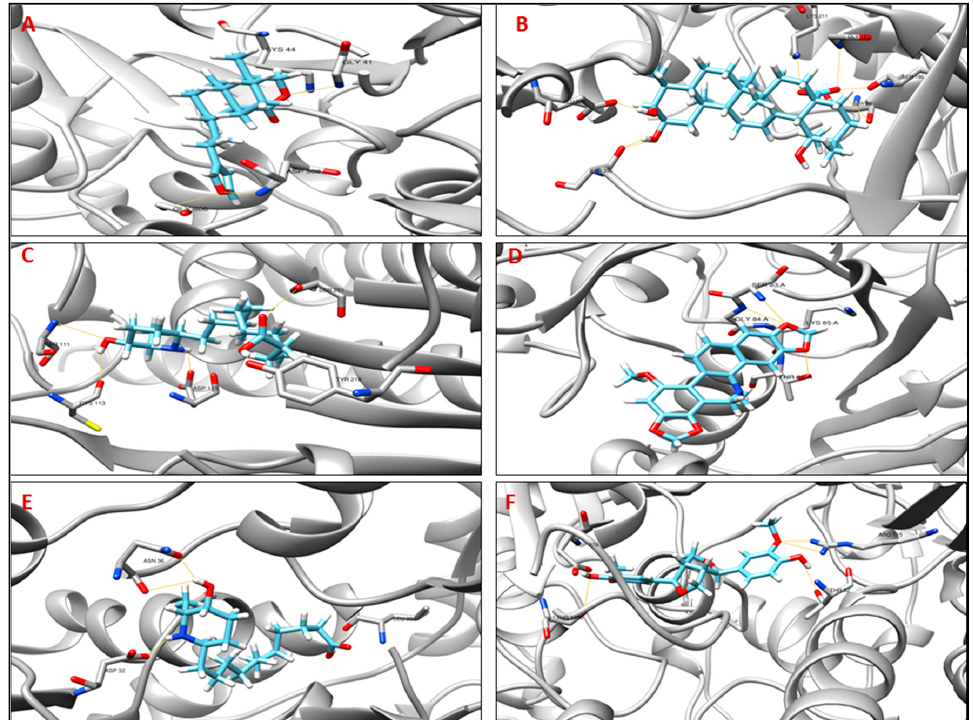
Figure 3. 3D graphic representation of the docking analyses for the most druggable protein cavity of drug target. ( A ) Tp_Nichols130 (uvrB, Uvr ABC system protein B) with potamogetonin (CID 5742898); ( B ) Tp_Nichols593 (pfp, pyrophosphate—fructose 6-phosphate 1-phosphotransferase) with jacarandic acid (CID 73645); ( C ) Tp_Nichols609 (asnA, aspartate-ammonia ligase) with leptophyllin B (CID 10447482); ( D ) Tp_Nichols754 (recA, RecA protein) with dihydrochelirubine (CID 440589); ( E ) Tp_Nichols9904 (ndh, NADH dehydrogenase) with leptophyllin B (CID